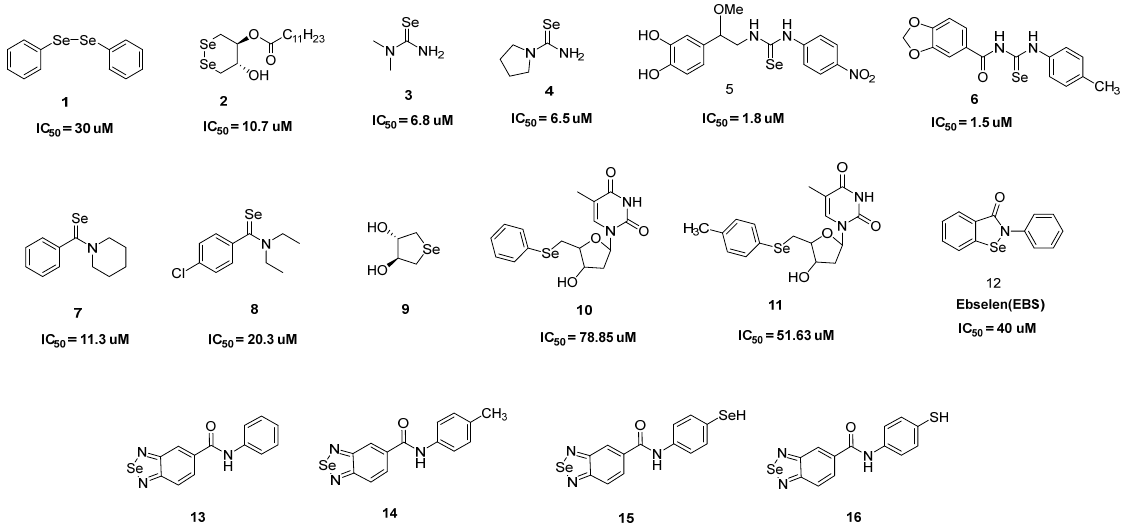
Figure 1. Selenium-containing compounds with antioxidant activity